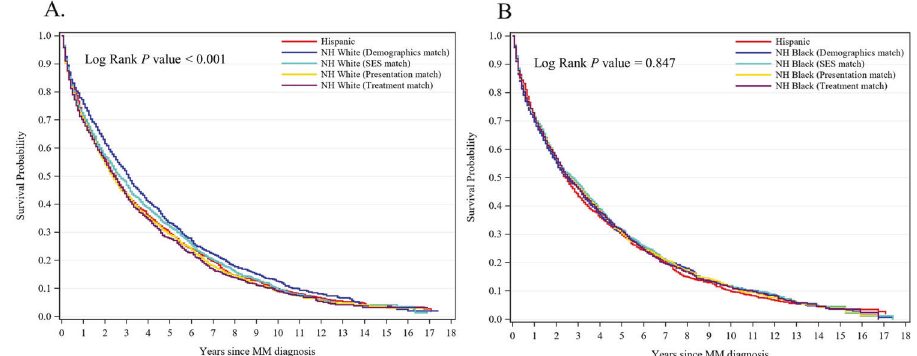
Fig. 1 Survival curve. A Life-Table plot for multiple myeloma survival for the total Hispanic population ( n = 1591) and the 4 matched non- Hispanic white populations (each n = 1591) diagnosed between 1999 and 2017. B Life-Table plot for multiple myeloma survival for a subset Hispanic population ( n = 1548) and the 4 matched non-Hispanic black populations (each n = 1548) diagnosed between 1999 and